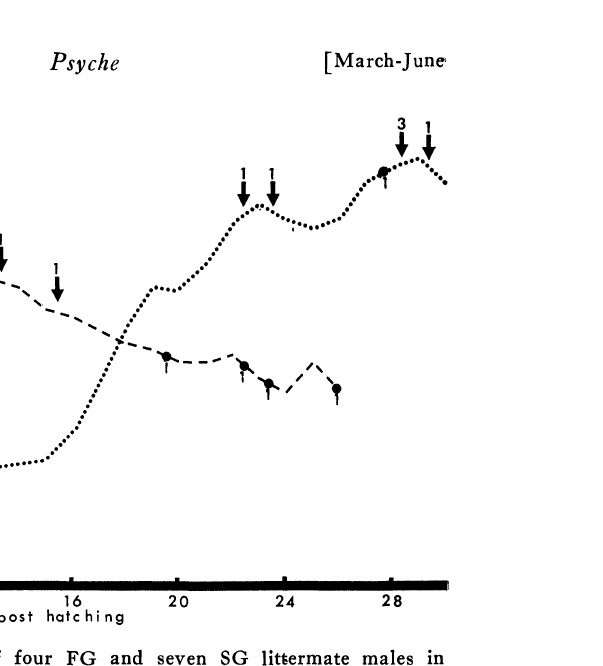
Figure 2. Body weight of four FG and seven SG littermate males in set I of draneus diadematus, hatched in the laboratory from one cocoon on February 23, 1972. Dashed line: weekly mean body weights of the FG males. Dotted line: weekly mean body weights of the SG male,s. Numerals followed by an arrow indicate the number of animals molting for the last time during a week. Numerals surmounted on black circIes indicate the number of animals dying during a week. The FG males reached their maximum weight the lSth week of post-hatching, the SG males reached their maximum the 29th week of post-hatching. Note that the SG animals need twice as much time to mature as the.